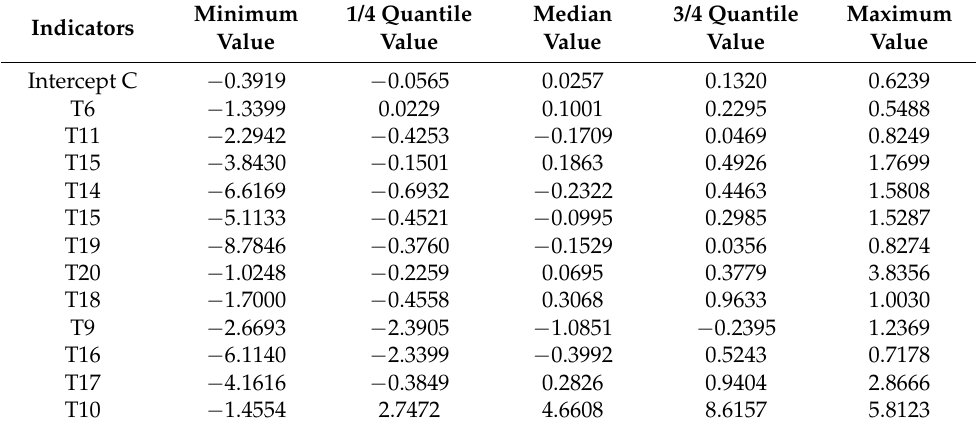
Table 3. GTWR parameter estimate summaries.